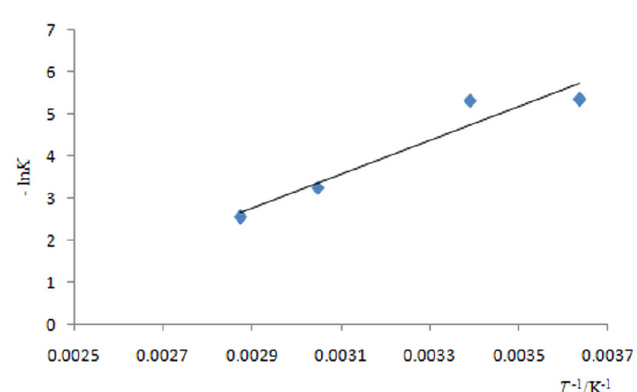
Fig. 2: Arrhenius plot for polyphenols degradation in Cornelian cherries extracts